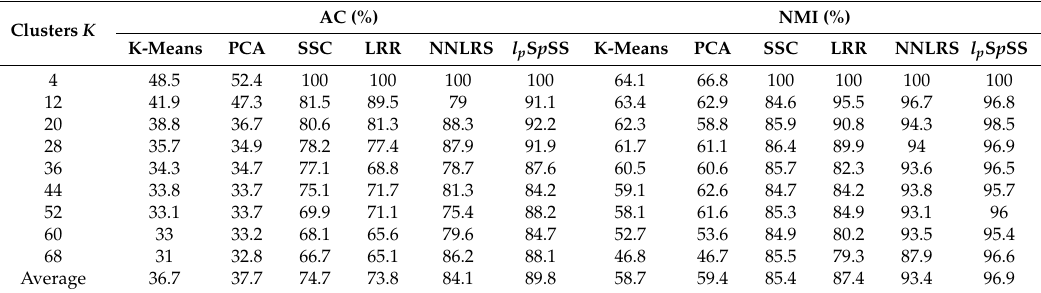
Table 1. Segmentation results of proposed and existing algorithms on the CMU-PIE dataset. Clusters K